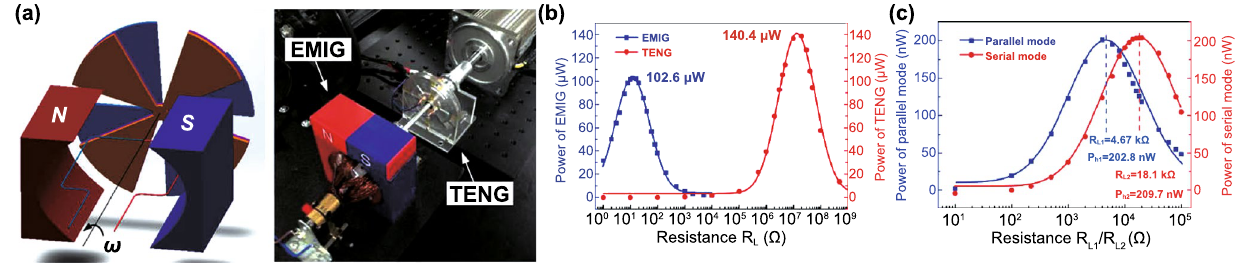
Fig. 8 a Schematic diagram and photograph of the original E-TENG hybrid generator developed by Zhang et al. b Output average power of the rotating DC-EMG and DC-TENG cells with different external resistive load. c Output power of the combined generators connected to imped- ance matching resistors and in parallel and series between themselves. Reproduced with permission from Ref. [63]. Copyright 2014, Advanced Materials. (Color figure